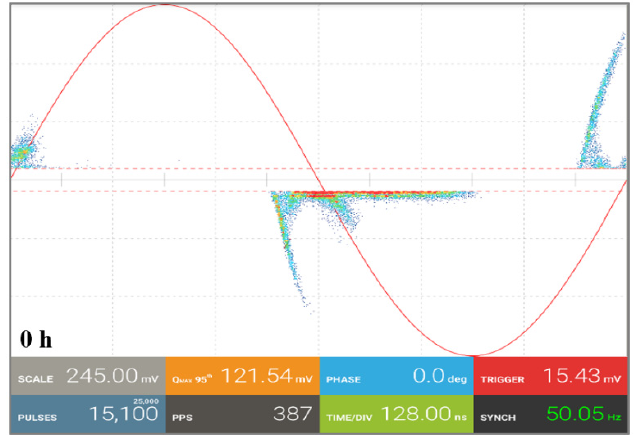
Figure 4. PRPD pattern under AC stress acquired after a few minutes of voltage application.